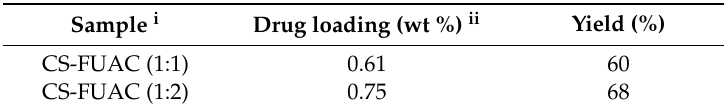
Table 1. Reaction data for CS-FUAC conjugates.